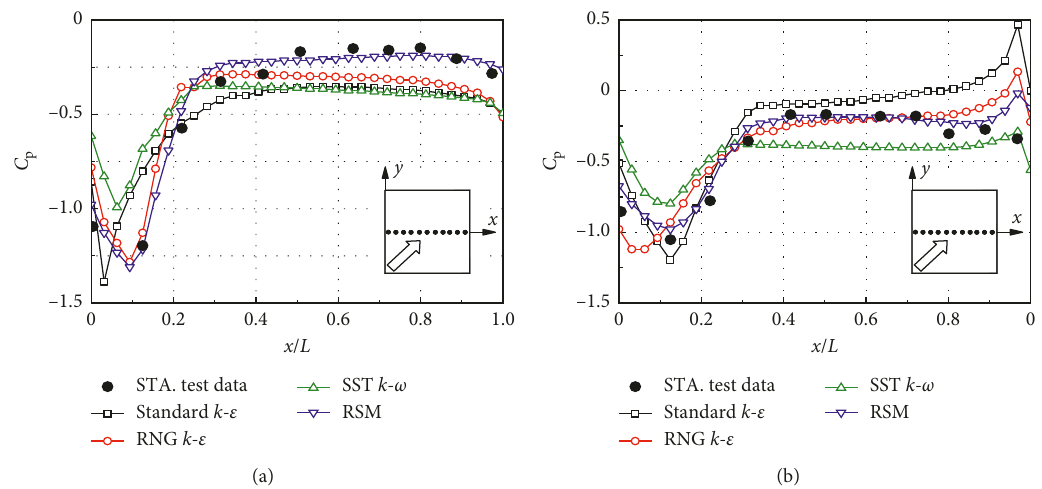
� 0, no parapet. p / H